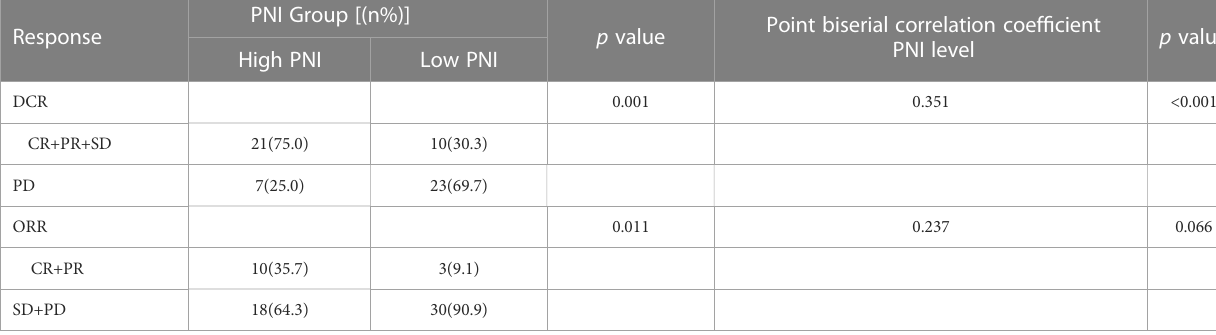
TABLE 2 Relationship between clinical response and PNI groups in SCLC patients treated with PD-L1/PD-1 inhibitors monotherapy.